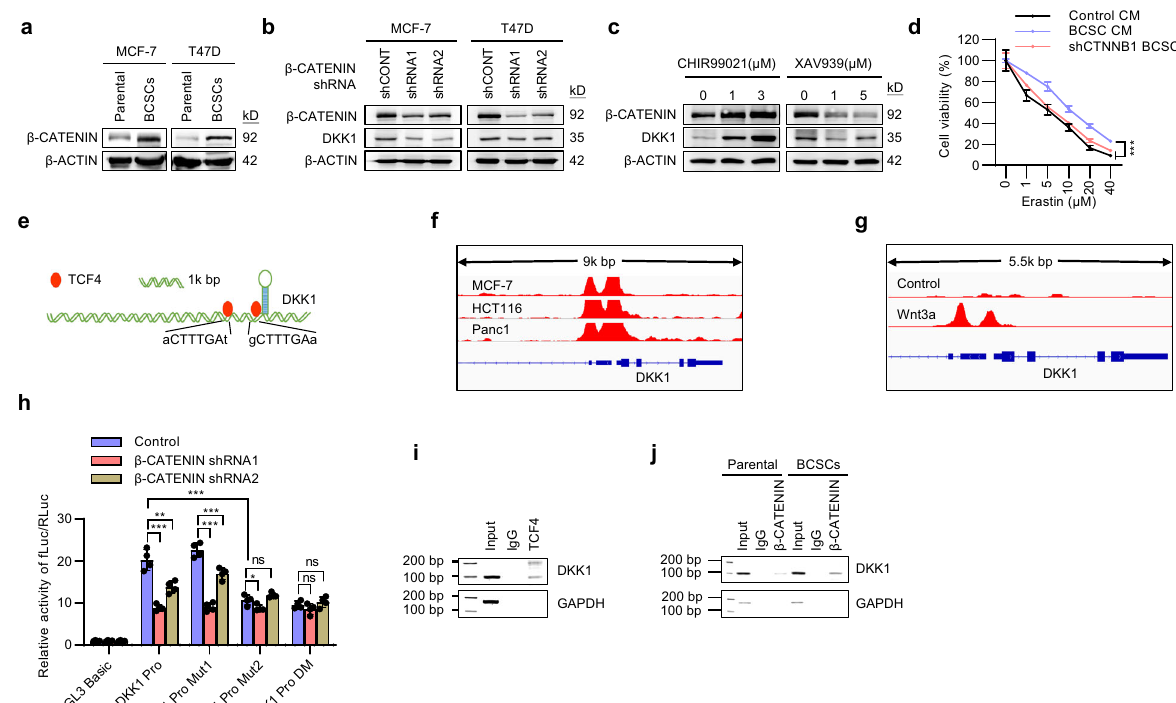
Fig. 7 β -CATENIN regulates the transcription of DKK1. a Immunoblot assessment of the protein levels of β -CATENIN in the matched mammosphere- enriched BCSCs and parental MCF-7 or T47D cells. b Immunoblot assessment of the protein levels of β -CATENIN and DKK1 in MCF-7 or T47D cells transfected with two different β -CATENIN shRNAs. c Immunoblot assessment of the protein levels of β -CATENIN and DKK1 in MCF-7 cells treated with CHIR99021 or XAV939. d Cell viability of MCF-7 cells cultured with the CM derived from parental cells or mammosphere-enriched shCONT BCSCs or shCTNNB1-BCSCs and treated with a graded concentration of Erastin for 48 h. e Schematic representation of the predicted TCF4 binding sites in the DNA promoter region of DKK1 based on rVista 2.0 software. f ChIP-sequencing data shows the enrichments of TCF4 around the promoter region of DKK1 in MCF-7, HCT116, and Panc1 cells (GSE31477). g ChIP-sequencing data shows the enrichments of β -CATENIN around the promoter region of DKK1 in cells treated with or without Wnt3a (GSE64758). h Regulation of wild-type or mutant (TCF4 binding site deleted) DKK1 promoter activities by β -CATENIN were determined by luciferase reporter assay. Renilla luciferase activity as input control. i Binding of TCF4 to the DKK1 promoter region in MCF-7 cells was examined by ChIP assay. j The binding of β -CATENIN to the DKK1 promoter region in BCSCs or parental MCF-7 cells was examined by ChIP assay. Results are shown as mean ± S.D. * P < 0.05; ** P < 0.01; *** P < 0.001; ns not signi fi cant (One-way ANOVA followed by Tukey ’ s multiple comparison test in ( h ), others two-way ANOVA test). Source data are provided as a Source Data fi